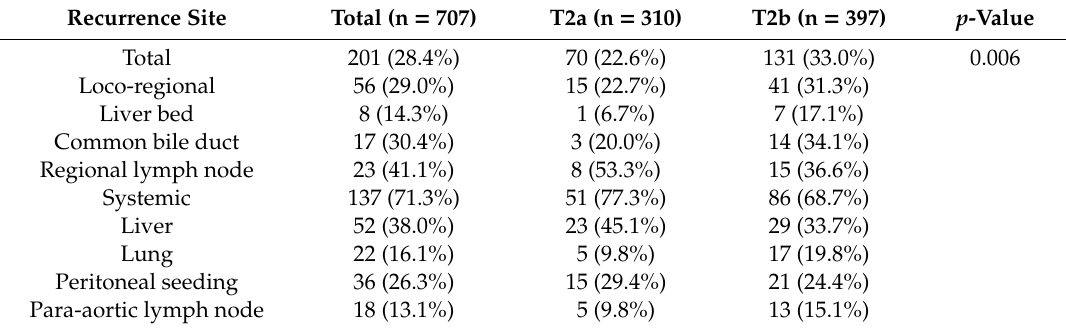
Table 2. Recurrence patterns and sites according to tumor location.